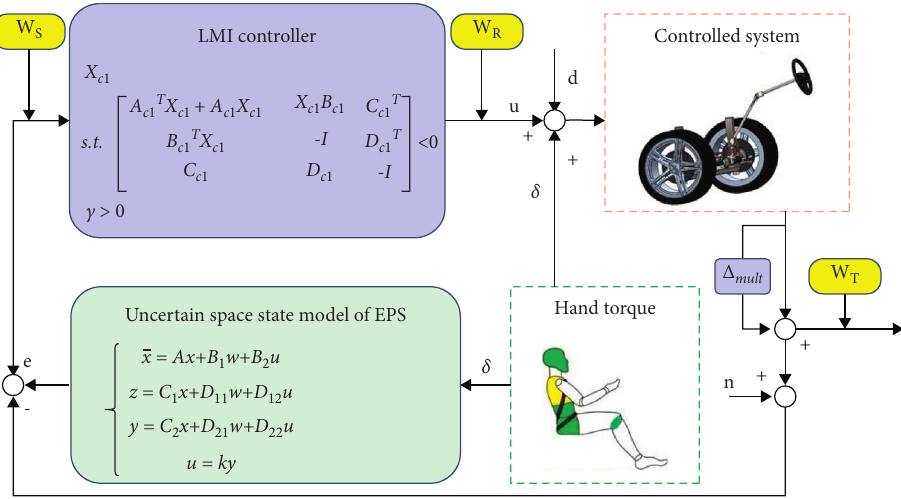
Figure 6: The control